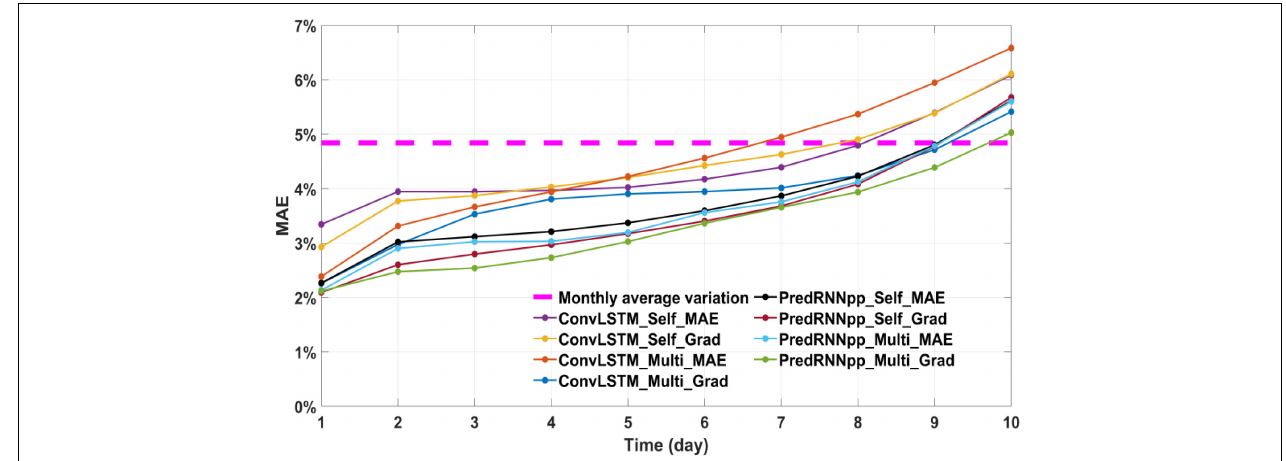
FIGURE 4 | The magenta dashed line in the figure represents the monthly average MAE; the remaining 8 solid lines represent the average MAE of eight models for 10 consecutive days in October 2020.